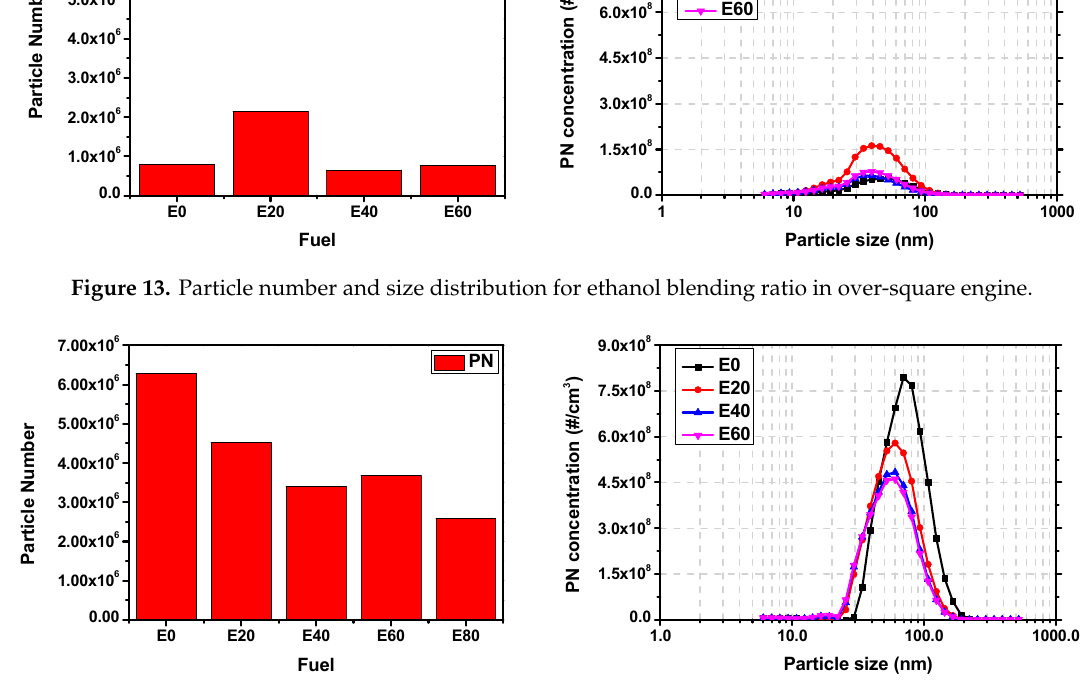
Figure 14. Particle number and size distribution for ethanol blending ratio in under-square engine .